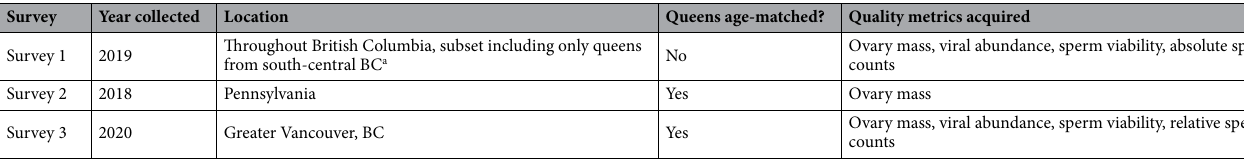
Table 1. Summary of queen surveys. a These queens were chosen from a previously published dataset 35,41 because failed and healthy queens were included in the same shipment, eliminating potential extraneous variables associated with